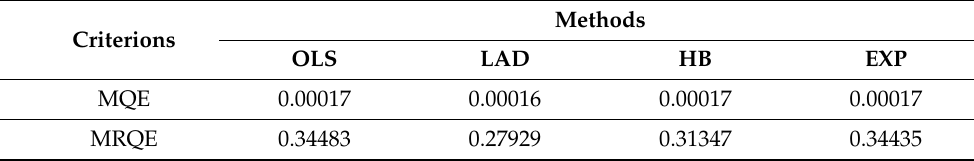
Table 5. MQE and MRQE of three estimation methods under the SFLAR